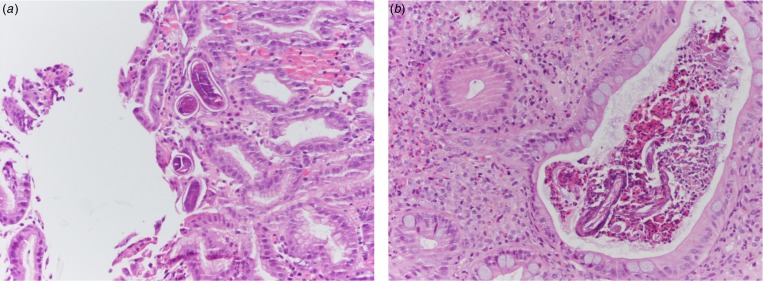
(a) Histological specimen from gastric biopsies of patient 1. Evidence of numerous S. stercoralis larvae in crypts (H&E 20× magnification). (b) Histological specimen from colonic biopsies of patient 2. Eosinophilic crypt abscess with evidence of Strongyloides larvae and eggs. The surrounding lamina propria shows a dense inflammatory infiltrate rich in eosinophils (H&E 20× magnification).